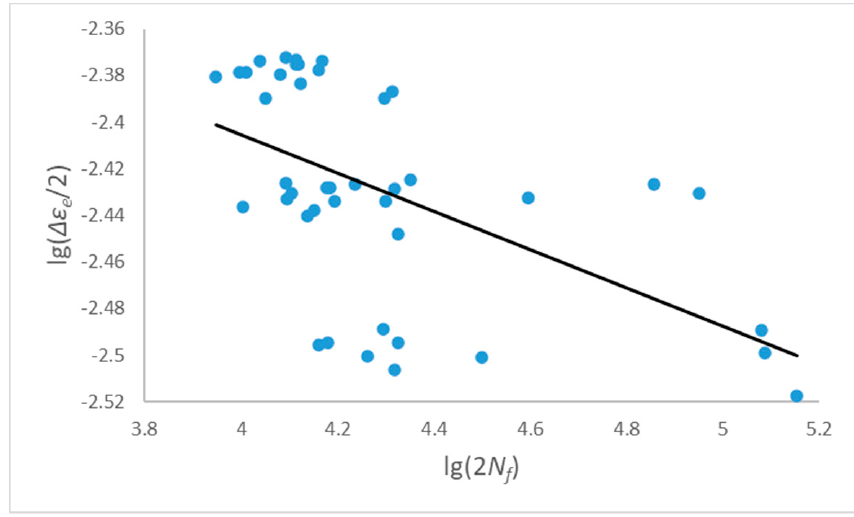
Table 3. Experimental conditions at 600 °C.